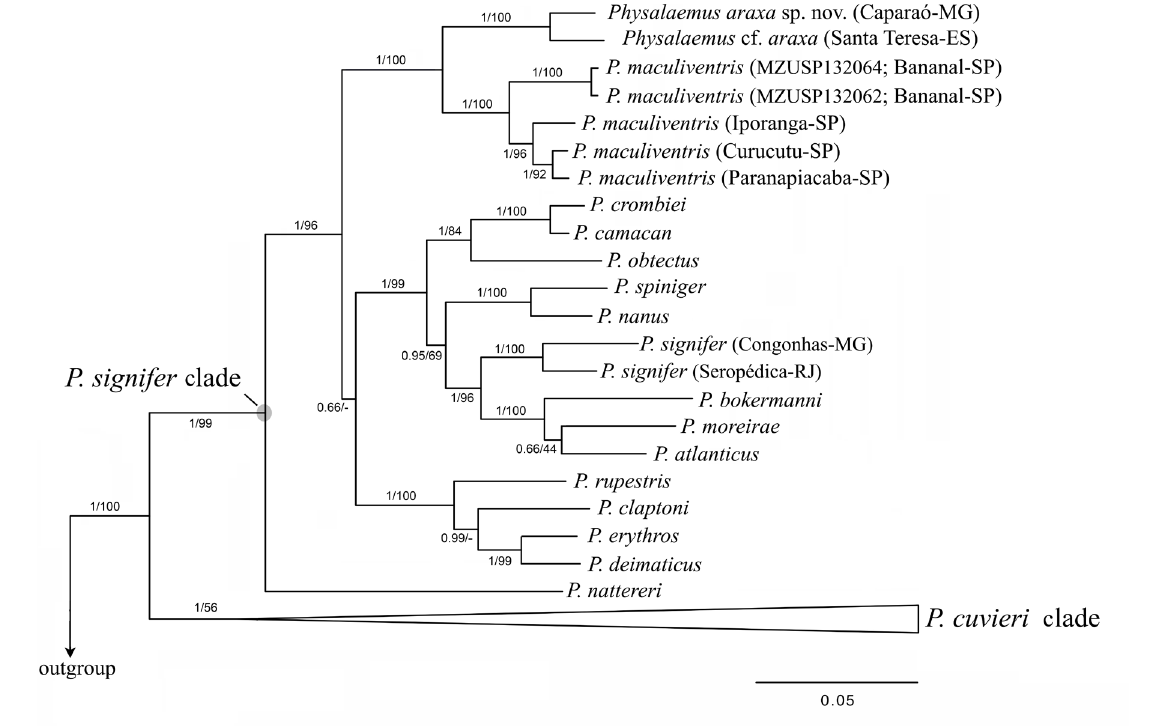
Fig. 8. Interspecific phylogenetic relationships of Physalaemus araxa sp. nov. inferred from 12S rRNA, tRNA-val, and 16S rRNA mitochondrial genes (H1 fragment sequences) by MrBayes and TNT. Numbers indicate posterior probabilities (left) or bootstrap values (right) in the MrBayes and TNT analyses, respectively. Hyphens indicate nodes that were not recovered in the TNT analysis.